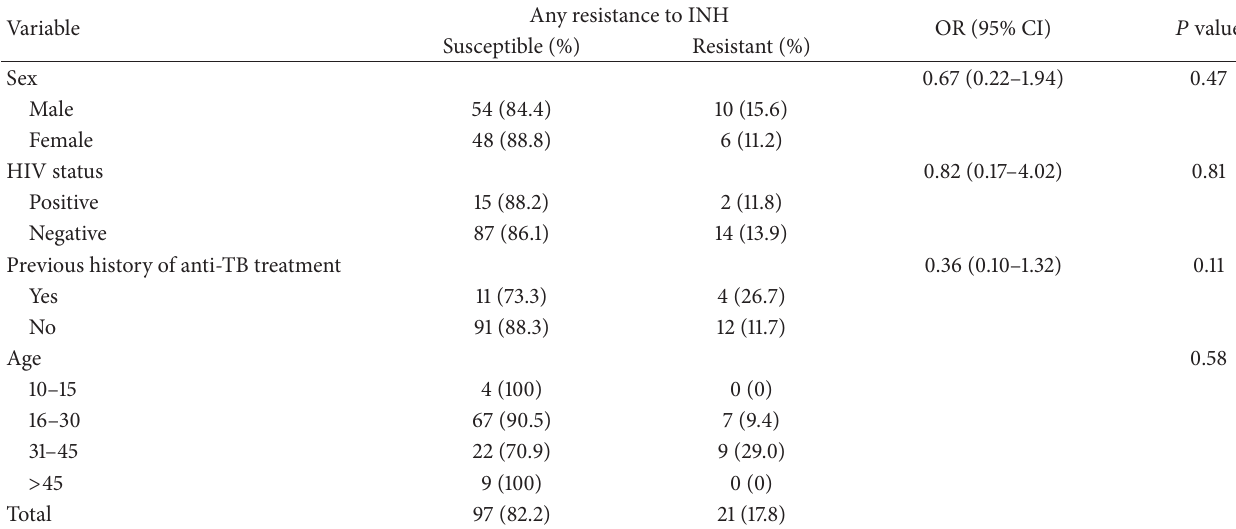
Table 2: The risk of any resistance to INH by gender, HIV status, previous anti-TB treatment, and age group assessed using the Chi square test.